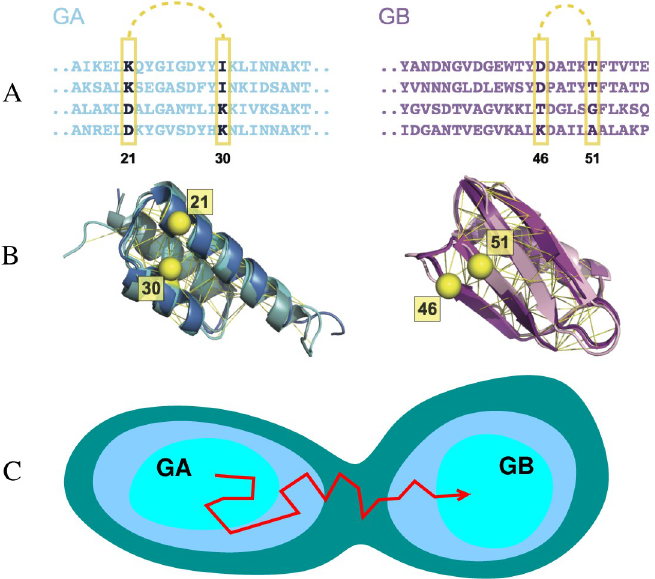
Fig 1. Sequence-based models for the GA and GB domains of streptococcal protein G. Many sequences (A) fold to each structure (B): e.g. structures of three naturally occurring sequences with the GA fold (pdb ID 2fs1, 1gjs and 2j5y) and three with the GB fold (pdb ID 1pga, 2lum and 1igd) are shown on the left and right respectively. Contacts between pairs of residues in the native structure (C β atoms of example pairs in yellow) impose mutual constraints on the types of residues which can occupy these positions in the sequence alignment. For instance, strong covariance is detected between the amino acids at residue 21 and 30 for GA sequences and between residues 46 and 51 for GB sequences. The C β atoms of these residues are illustrated in yellow sphere. The UniProtKB ID of these example sequences for GA are Q51918_FINMA, G5KGV3_9STRE, G5K7M6_9STRE and Q56192_STAXY. And the ones for GB are SPG1_STRSG, E4KPW8_9LACT, F9P4J6_STRCV and G5JZF8_9STRE. (C) Simple model for the emergence of new folds via evolutionary drift in sequence space between basins of attraction corresponding to the GA and GB